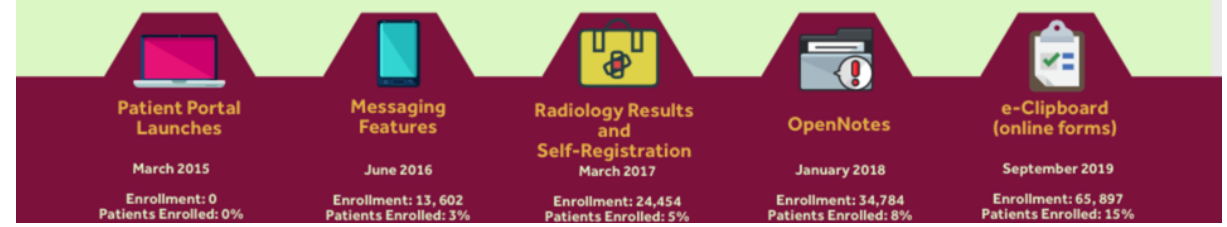
Figure 1. Los Angeles County Department of Health Services portal features timeline and percentage of empaneled primary care patients enrolled at each stage.